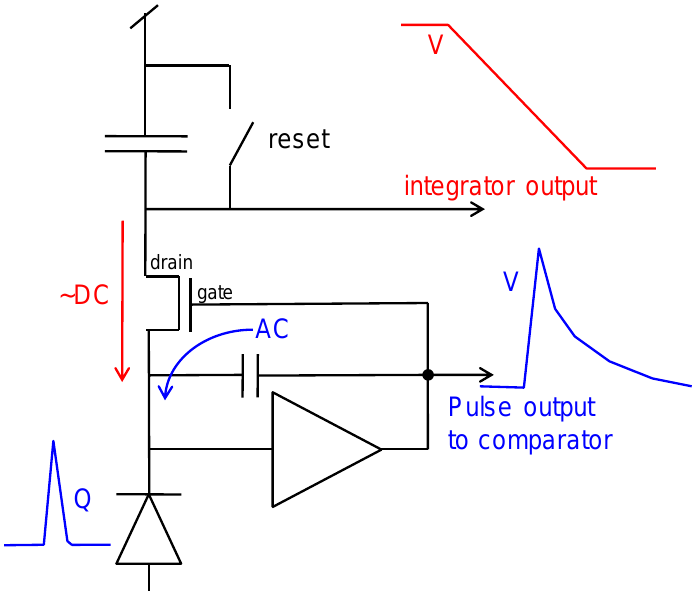
Figure 16. Concept circuit of a pulse shaper that feeds its photocurrent to a charge integrator. This integrator in itself reminds us of the well-known integrating 3T pixel. The extra circuitry compared to the photon counter is small. The overall pixel may look like the illustration in Figure 17.